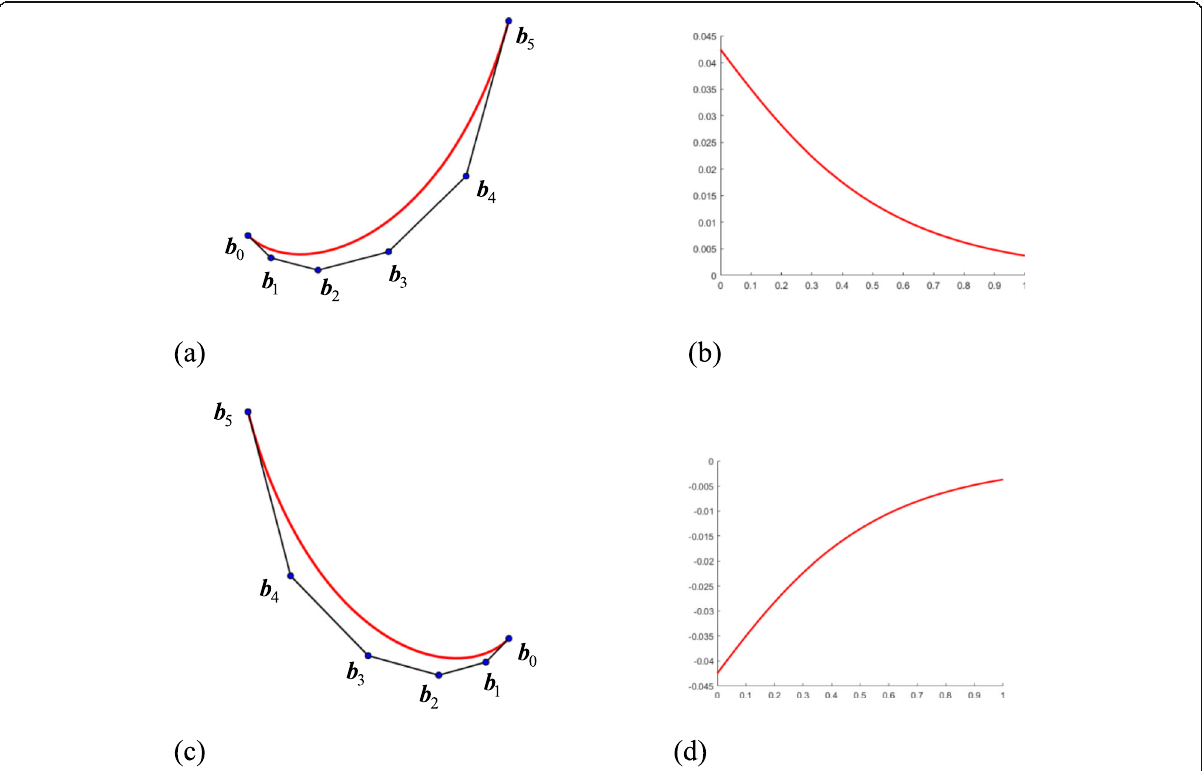
(cid:2) , s > 1, and s ⋅ cos θ ≥ 1; b : The curvature is positive and 2